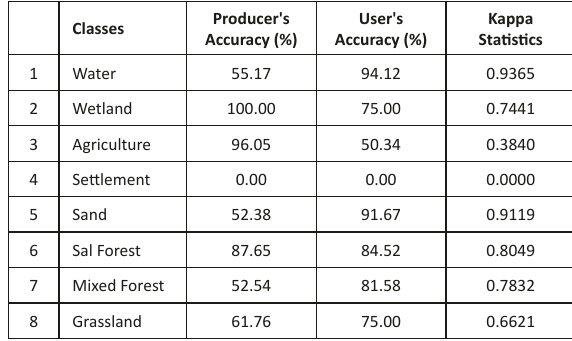
Table 1. Errors of commission (User’s Accuracy), errors of omission (Producer’s Accuracy), and kappa statistics for classification of 2003 Landsat ETM image [Overall accuracy was